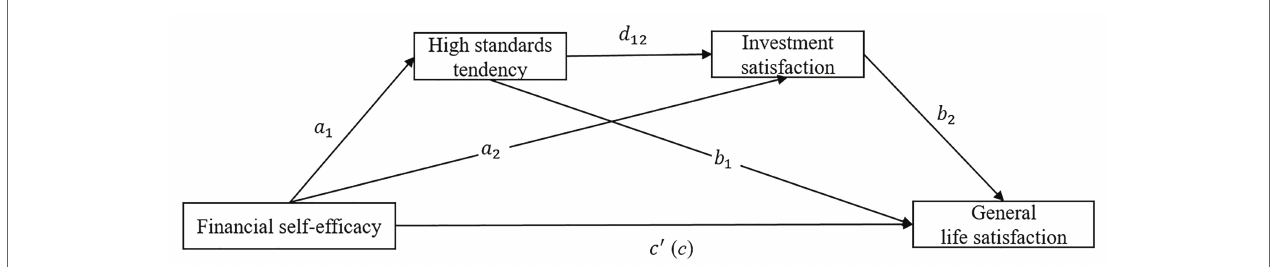
FIGURE 1 | The hypothesized research